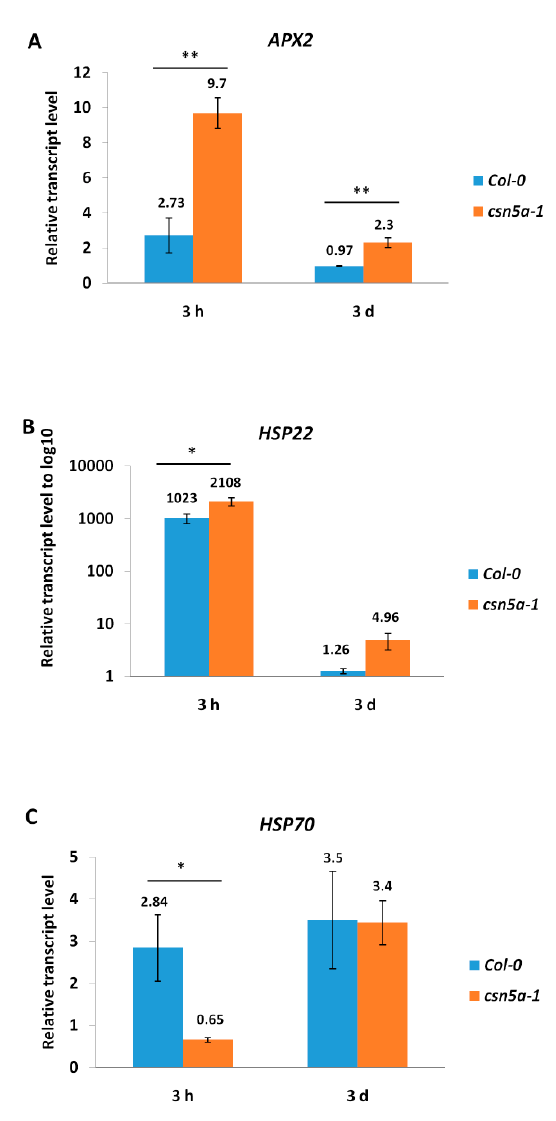
Figure 2. CSN5A regulates the heat stress memory genes after recurrent heat stress. ( A ) Relative transcript level of APX2 3 h and 3 d after recurrent heat stress (2 h, 44 ◦ C, 7 d) in Col-0 (blue) and csn5a-1 (orange). ( B ) Relative transcript level of HSP22 3 h and 3 d after recurrent heat stress (2 h, 44 ◦ C, 7 d) in Col-0 (blue) and csn5a-1 (orange). ( C ) Relative transcript level of HSP70 3 h and 3 d after recurrent heat stress (2 h, 44 ◦ C, 7 d) in Col-0 (blue) and csn5a-1 (orange). Transcript levels were normalized by ACTIN and the respective non-heat stress (control) sample at the same point. Note that the Y-axis is in log 10 scale in graph (B). Error bars represent the standard error of the mean (SEM) of biological replicates ( n = 3). Student’s t test * p < 0.05; ** p < 0.01.